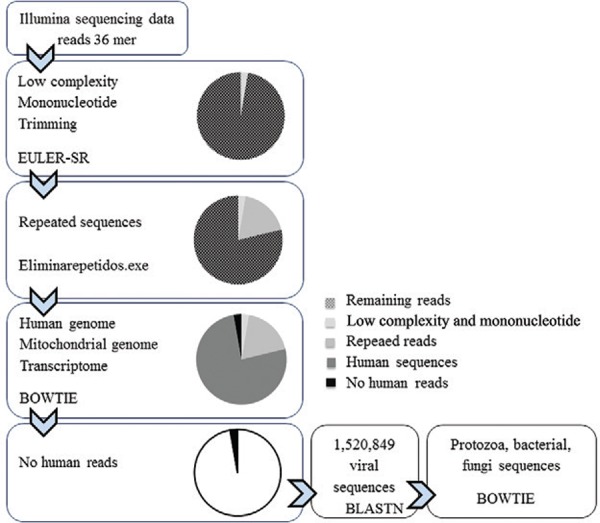
: pipeline of analysis of deep sequencing data. next-generation sequencing
crude data were enriched of viral sequences by subtracting unwanted reads as
follows: (i) filtering low-quality reads by EULER-SR, (ii) repeated sequences
by Eliminarepetidos.exe, (iii) human sequences aligning by BOWTIE, (iv) other
nonviral reads by aligning with BLASTN against publicly available sequence
databases (protozoan, bacterial, and fungi sequences). Pie charts illustrate
the subtracted and remaining non-human reads. For a more in deep explanation
see materials and methods.